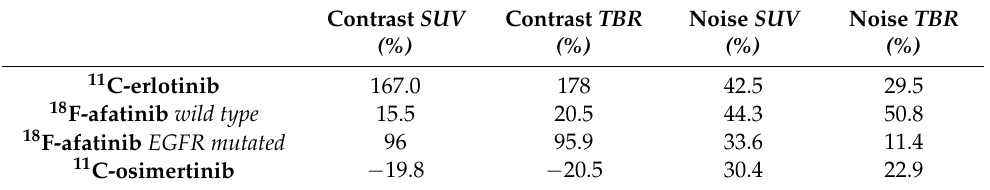
Table 4. Tumor-to-Lung Contrast and Noise Values.